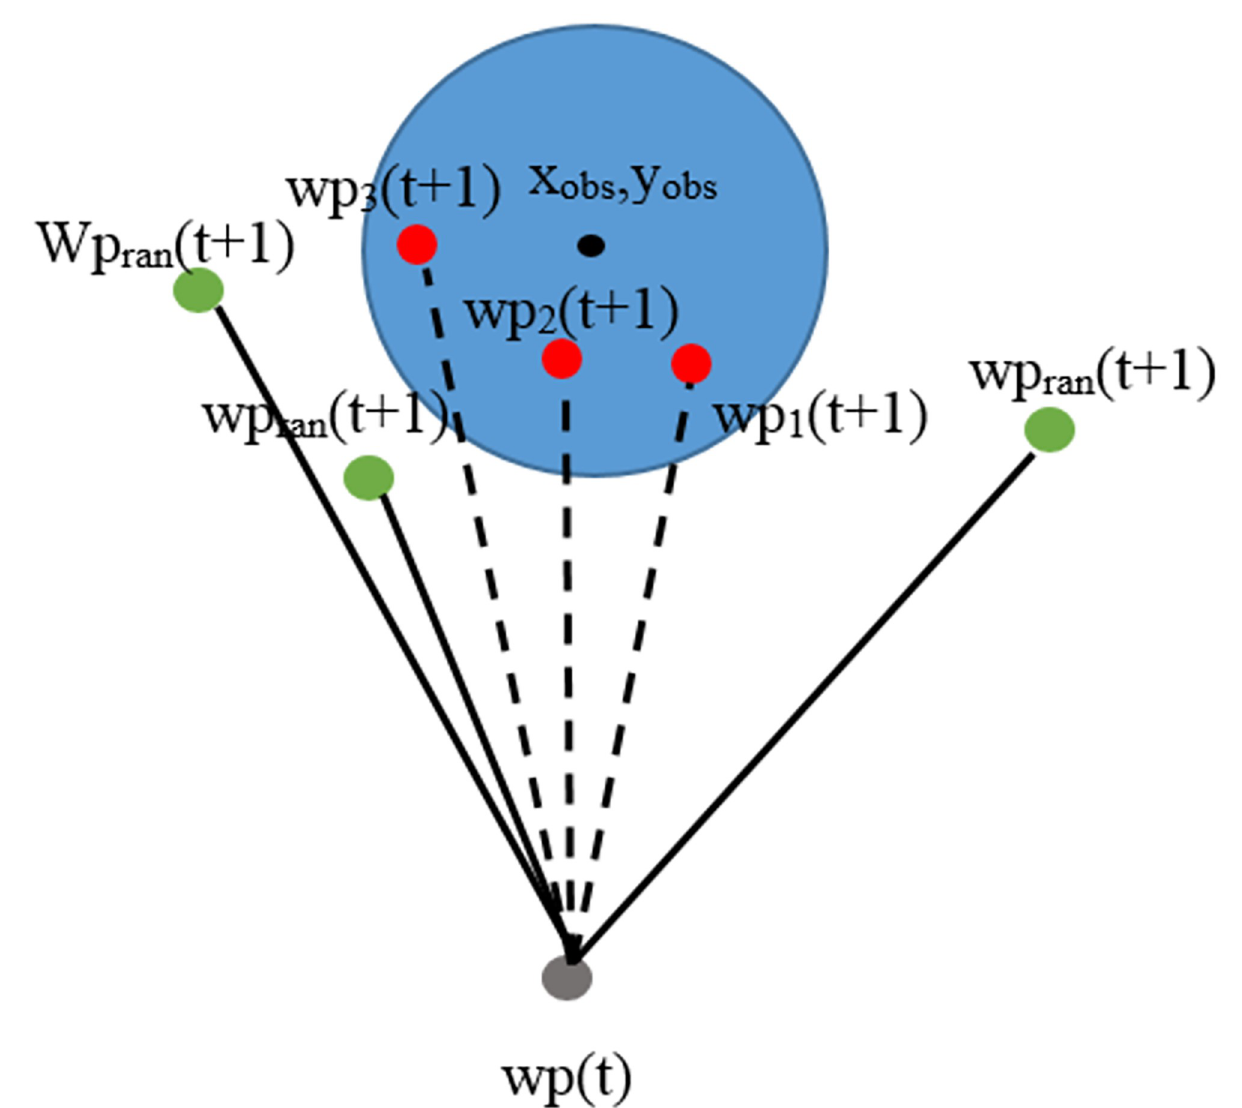
Fig 13. Infeasible waypoint handling when points are in